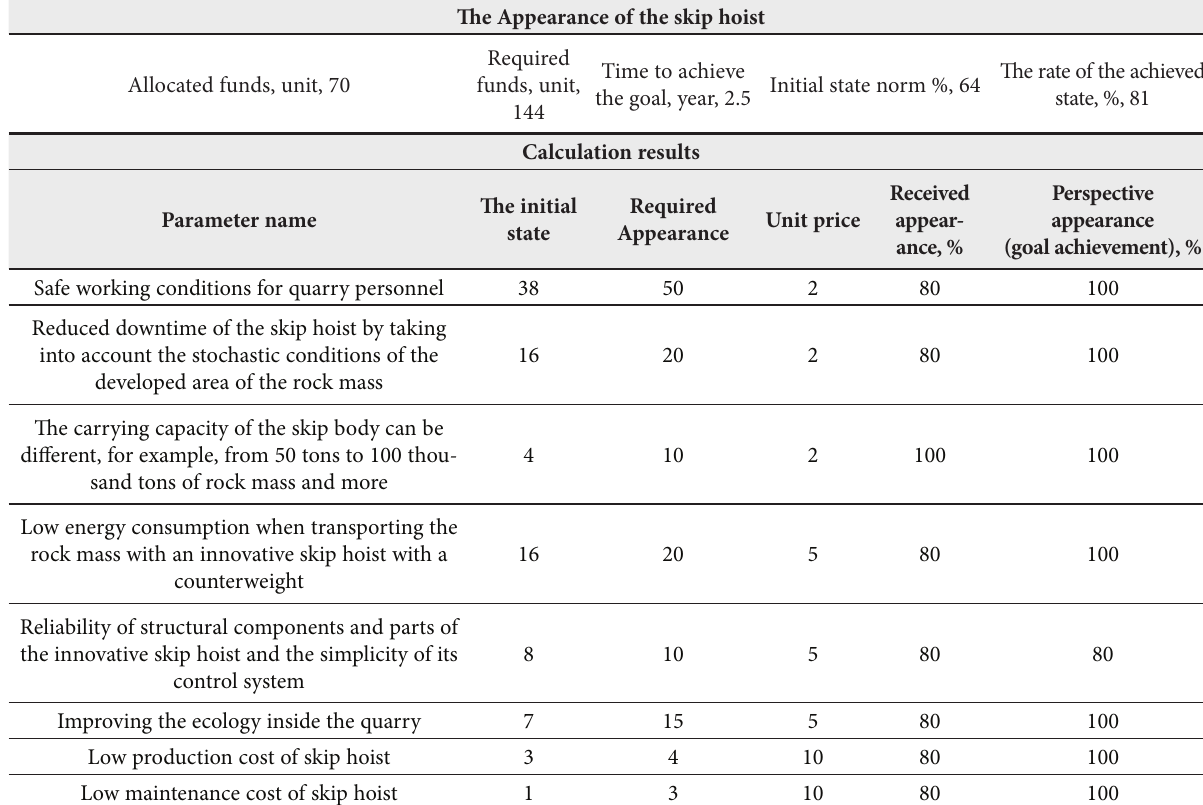
Initial data and calculation results of the perspective view of the skip hoist for a conditional example The Appearance of the skip